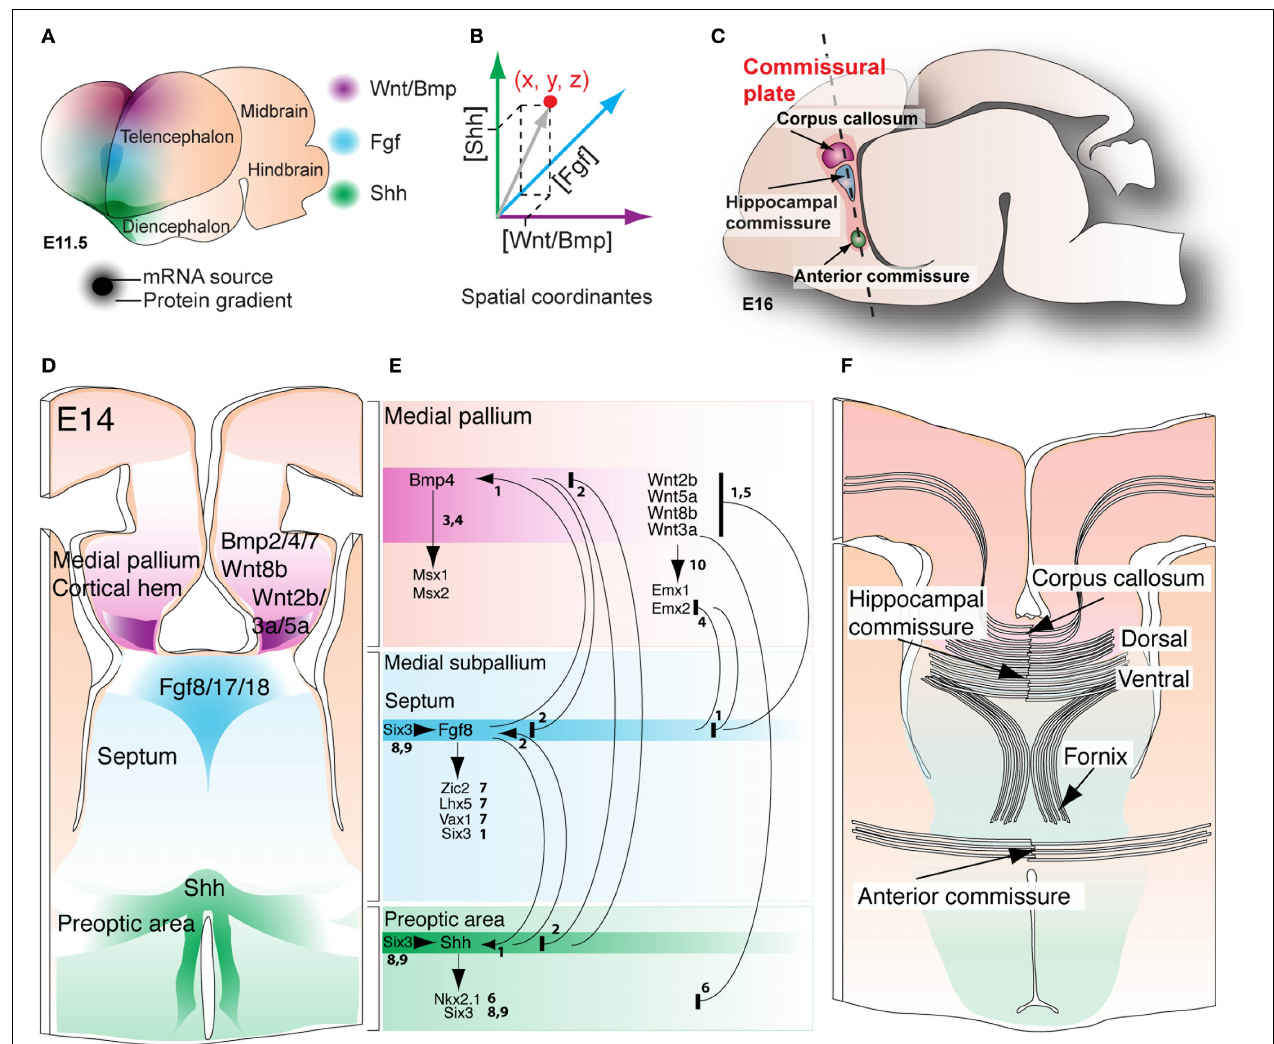
FIGURE 4 | Morphogenic patterning at the commissural plate. (A) Discrete regions of the early telencephalic midline of mice at E 11.5 express diffusible Wnt/Bmp, Fgf, and Shh proteins, as revealed by mRNA expression studies. (B) The differential concentration of each morphogen at any point in space results in distinct intracellular signaling outcomes, generating different cell fates. (C) A midsagittal schematic of the embryonic mouse brain showing the plane of section (D,F) defined by telencephalic commissures, known as the commissural plate. (D) Transverse section through the presumptive commissural plate at E14 shows the spatial extent of morphogen expression, mostly defining pallial, septal, and preoptic domains. (E) In general, morphogen interactions are